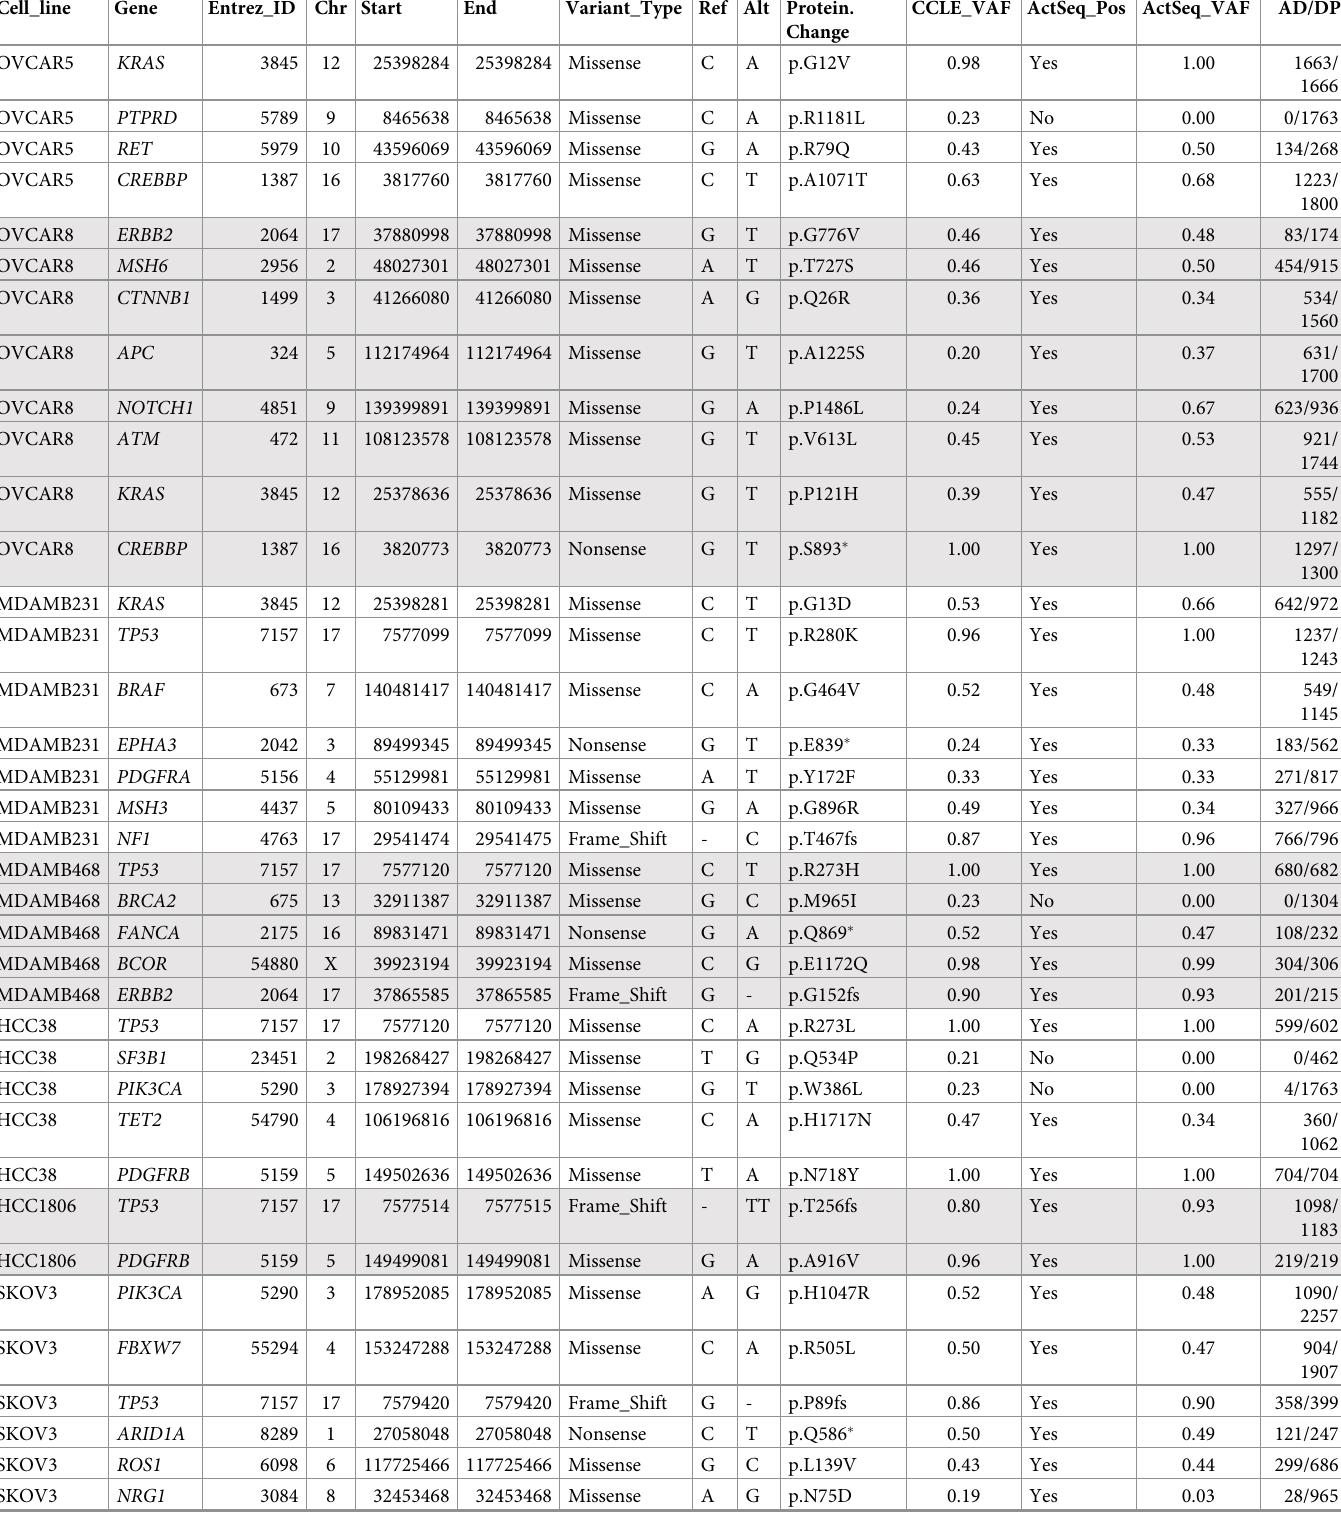
Table 3. CCLE cell lines variants as detected by ActSeq